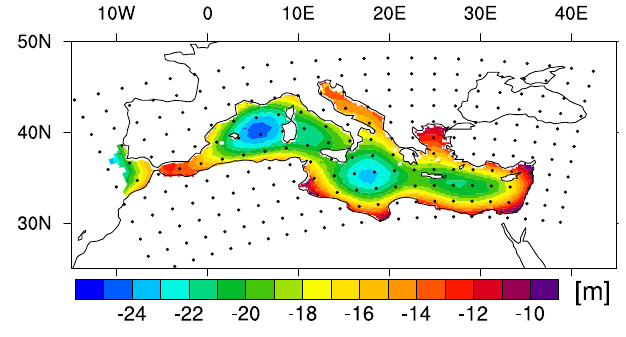
Fig. 1. Topography changes between 9K and CTRL. The superim- posed dots represent 1 of each 10 grid box centre of the model in each